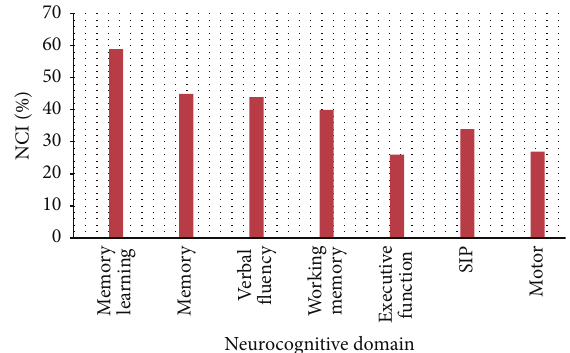
Figure 2: Percentage of the HIV-positive individuals with NCI by neurocognitive domain. NCI was defined as a score ≥ 2 SD below the mean of the HIV-positive individuals in the neurocognitive domain.